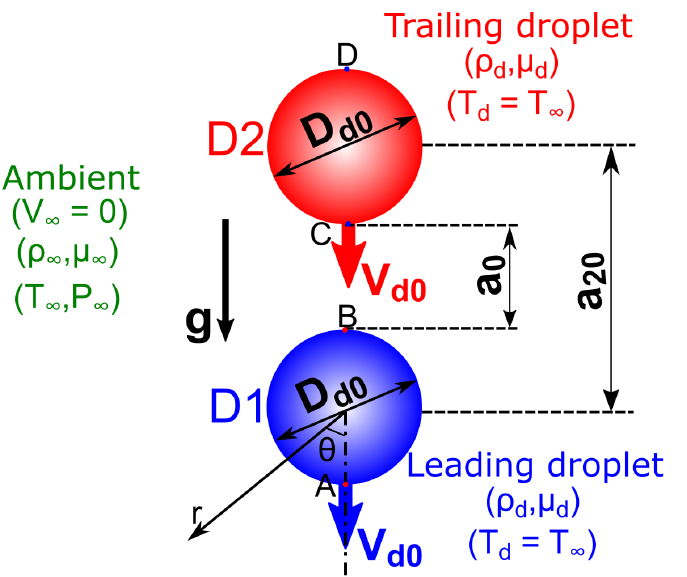
Figure 1. Schematic illustration of the double-droplet system at the instant t = 0, highlighting the relevant